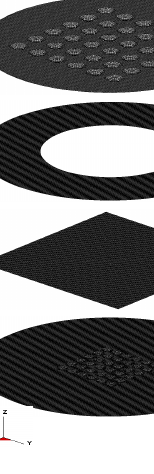
Figure 2. Finite element model.